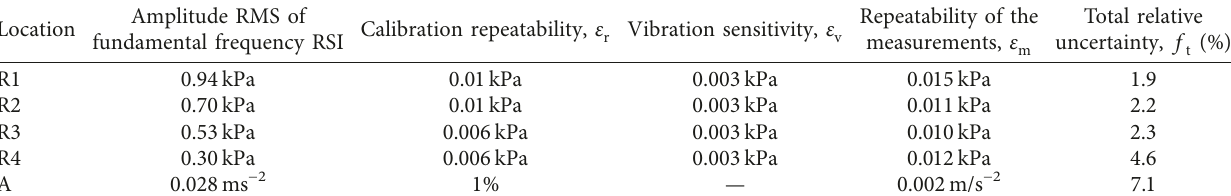
Table 2: Uncertainty budget for the fundamental RSI amplitudes,